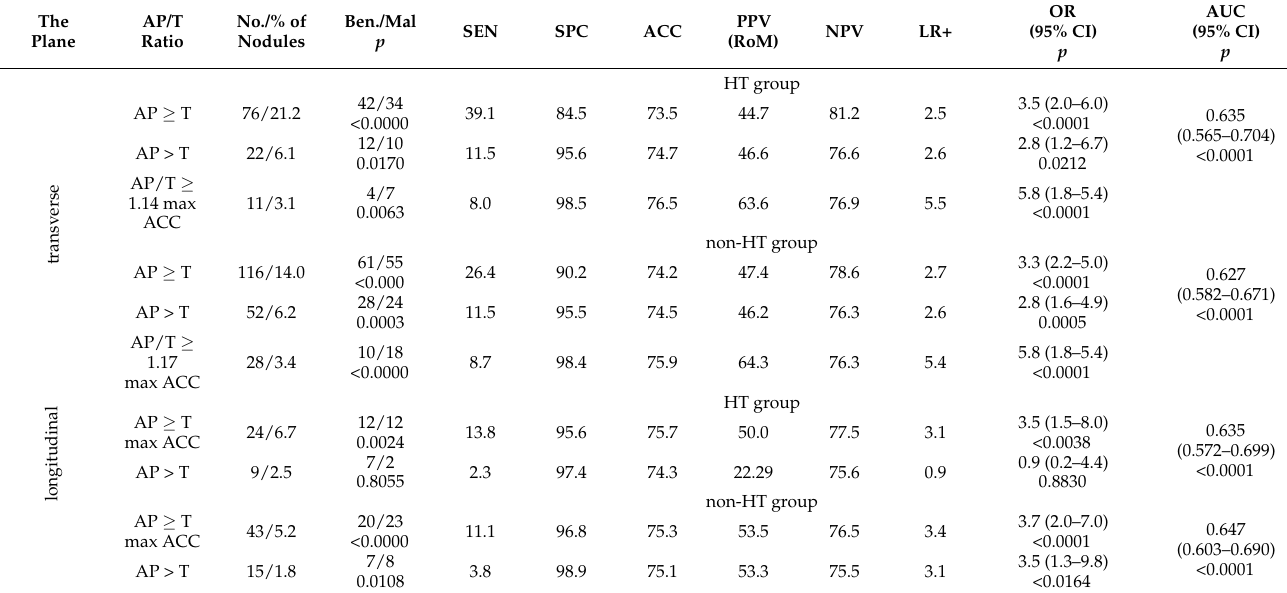
Table 1. Data on the diagnostic effectiveness of particular thresholds for AP/T ratio in examined groups of nodules (HT and non-HT). Evaluation of AP/T ratio on transverse and longitudinal